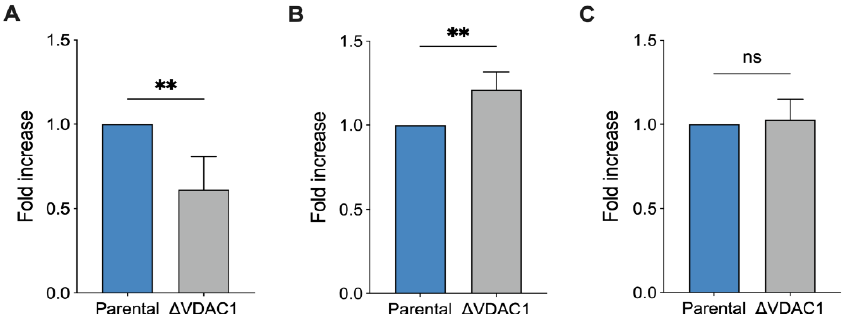
Figure 6. Analysis of NADH reduction in HAP1 cells. Quantitative analysis of total level of nicotinamide cofactors NAD + , NADH, NADP + , and NADPH ( A ), the ratio NAD + /NADH ( B ) and the overall level of lactate ( C ). The lower level of nicotinamide cofactors in ∆ VDAC1 cells is counterbalanced by high ratio of NAD + /NADH value. Data are expressed as fold increase using parental HAP1 as control. Data are shown as median ± SEM of n = 4 independent experiments and statistically analyzed by unpaired t -test, with ** p < 0.01; ns—not significant.